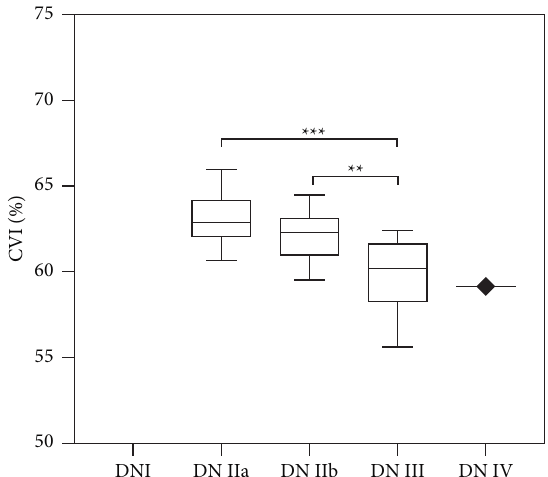
Figure 4: The CVI in different pathological stages of 45 patients with DN. CVI: choroidal vascularity index; DN: diabetic neph- ropathy. ∗∗ p < 0 . 01 and ∗∗∗ p < 0 . 001.